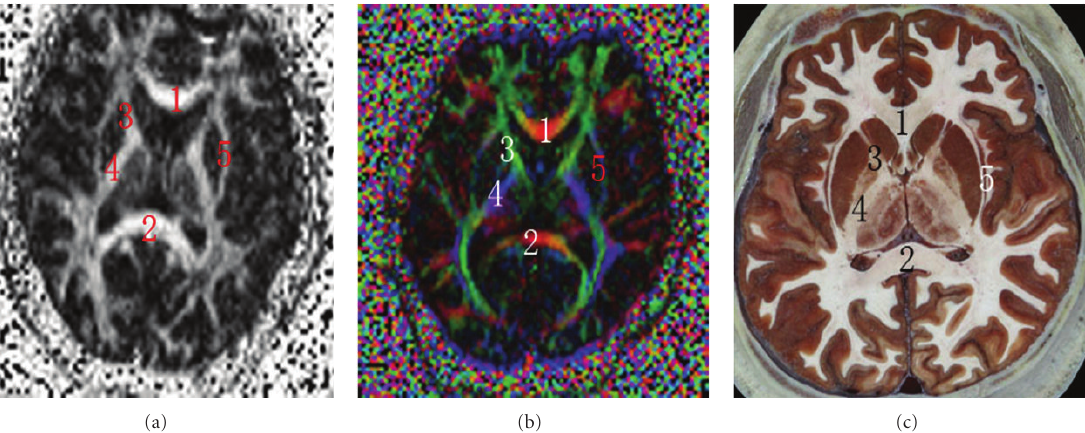
Figure 1: Transversal FA map, color tensor map, and sectional image of visible human at basal nuclei. (1) Genu of corpus callosum, (2) splenium of corpus callosum, (3) anterior limb of internal capsule, (4) posterior limb of internal capsule, and (5) external capsule and extreme capsule.